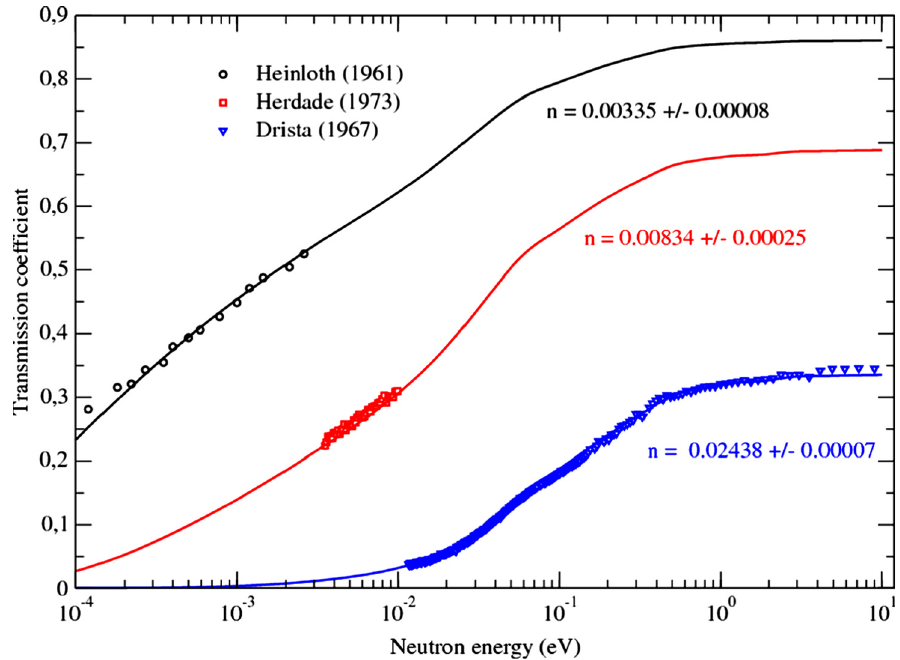
Fig. 4. Transmission coef fi cient at 294 K determined from the data reported in references [17 –